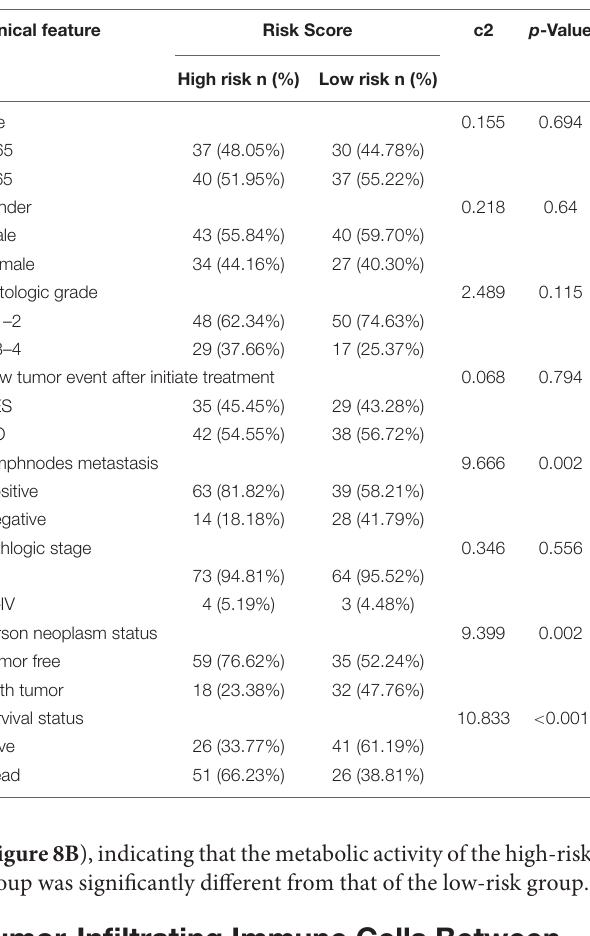
Frontiers in Genetics |